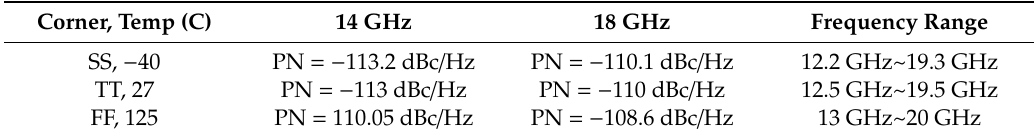
Table 1. Performance summary of the proposed VCO.